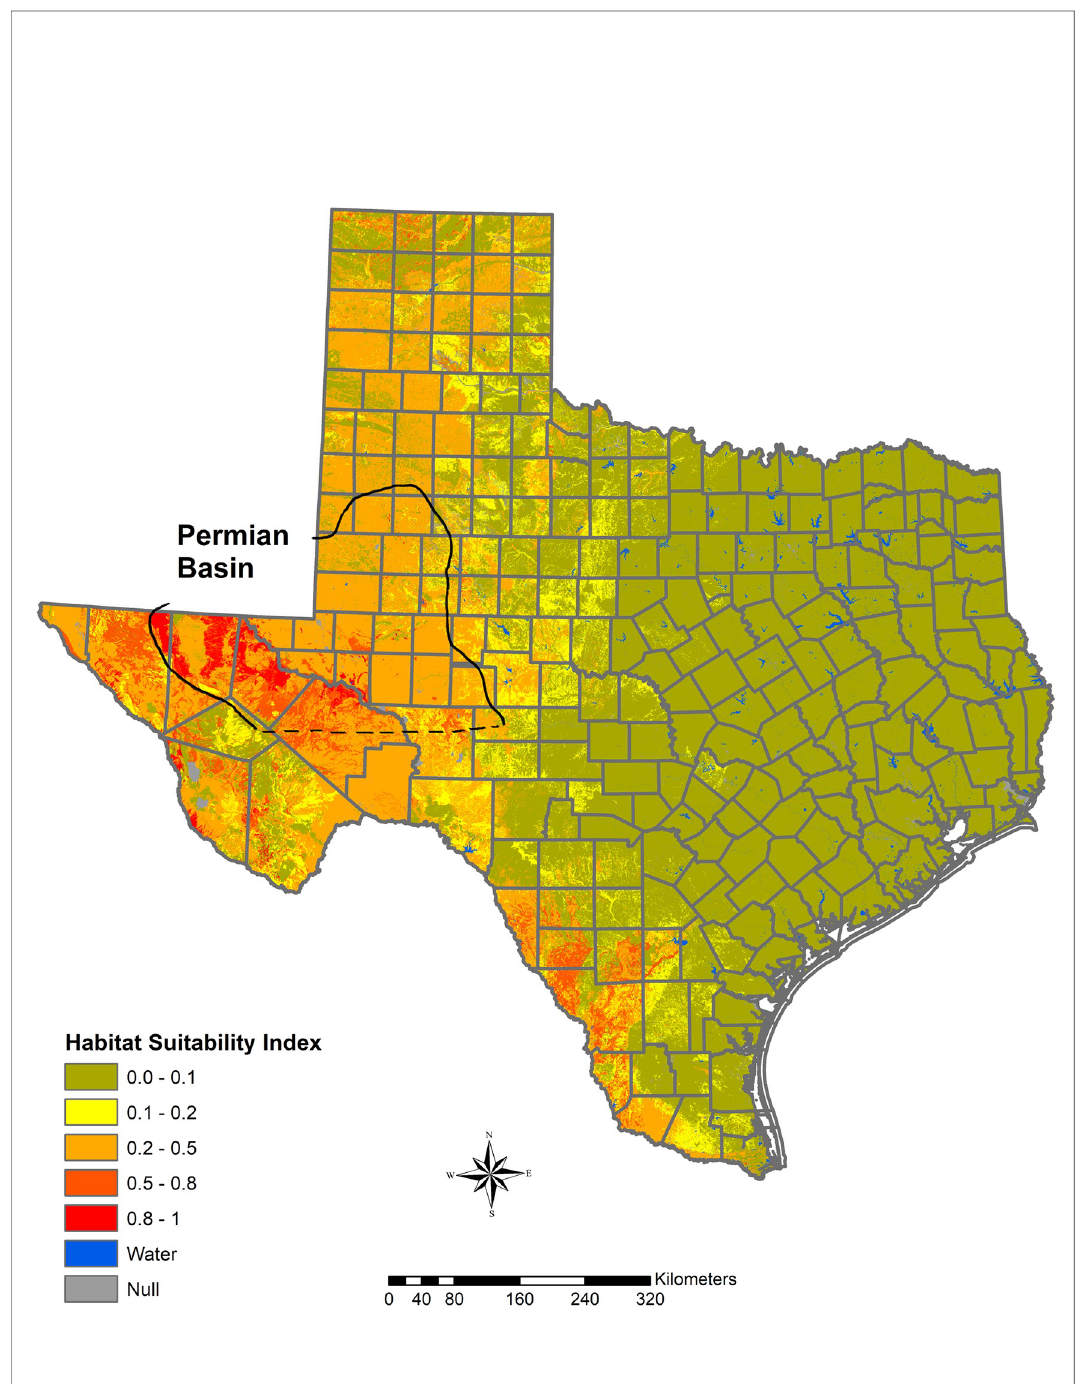
Fig 5. Predicted Coccidioides habitat suitability index for Texas.